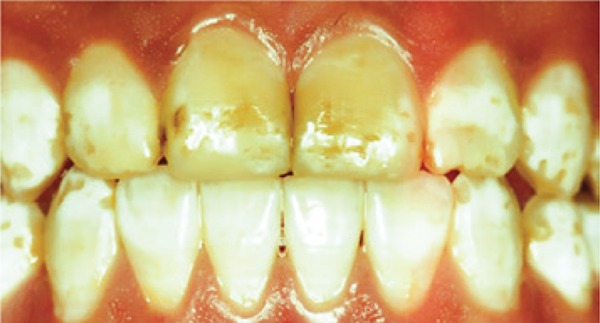
Dentes com fluorose severa